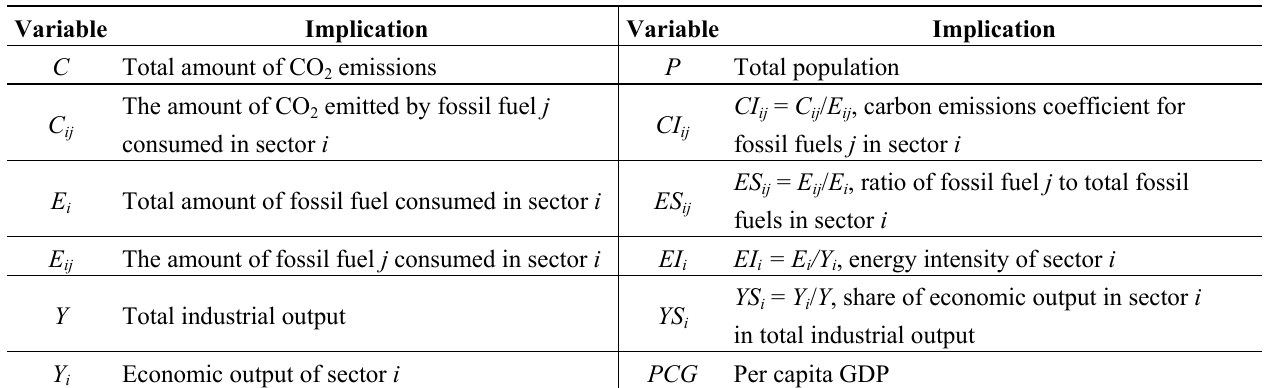
Table 2. Implication of each variable in Equation